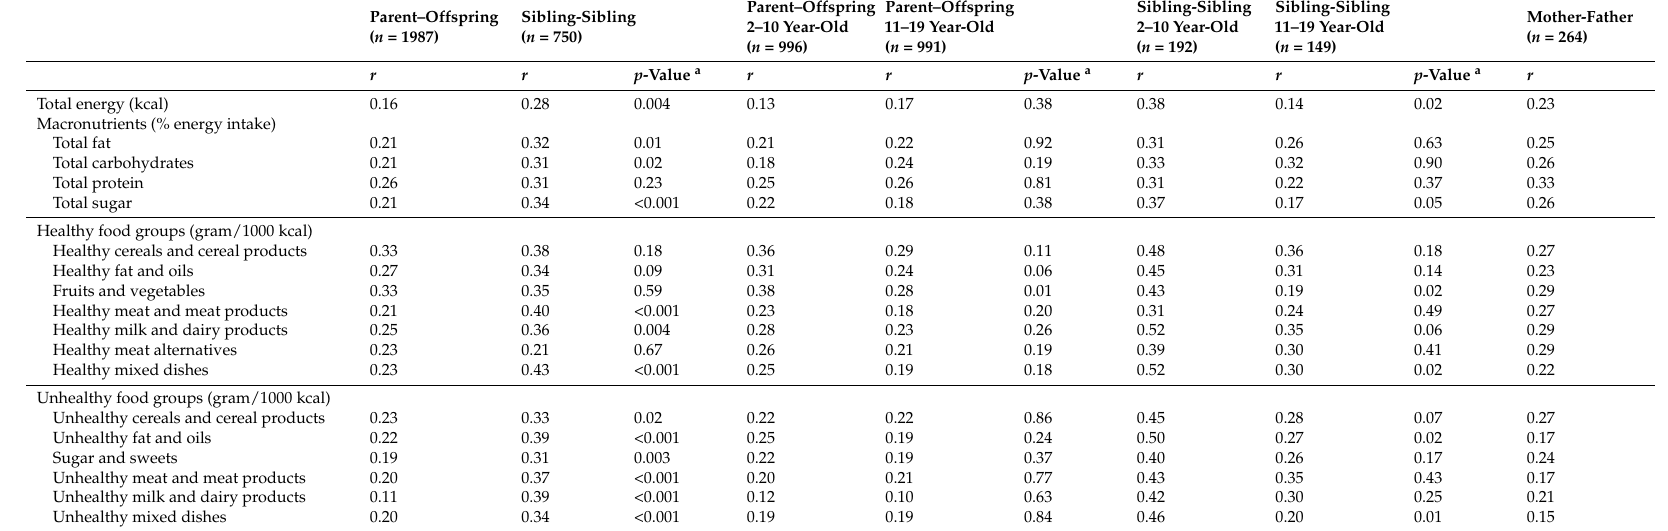
Table 3. Parent–offspring and sibling correlations in dietary intake for all subjects and separately for younger and older